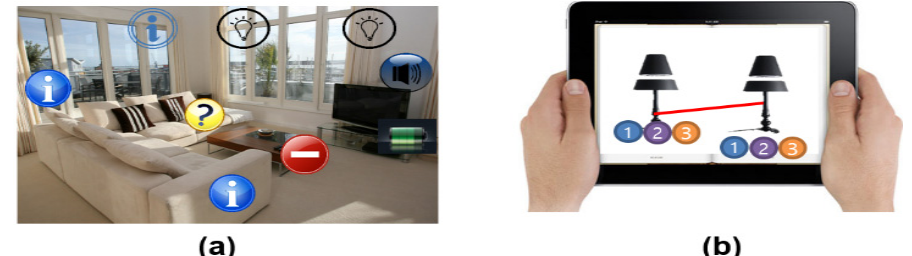
Figure 13. Augmented reality (AR) approach for interaction of everyday IoT objects: ( a ) interactive tool to define the operation of indoor IoT objects by hierarchical functional grouping [24]; ( b ) AR system to define the behavior of objects to create new functionalities [20].